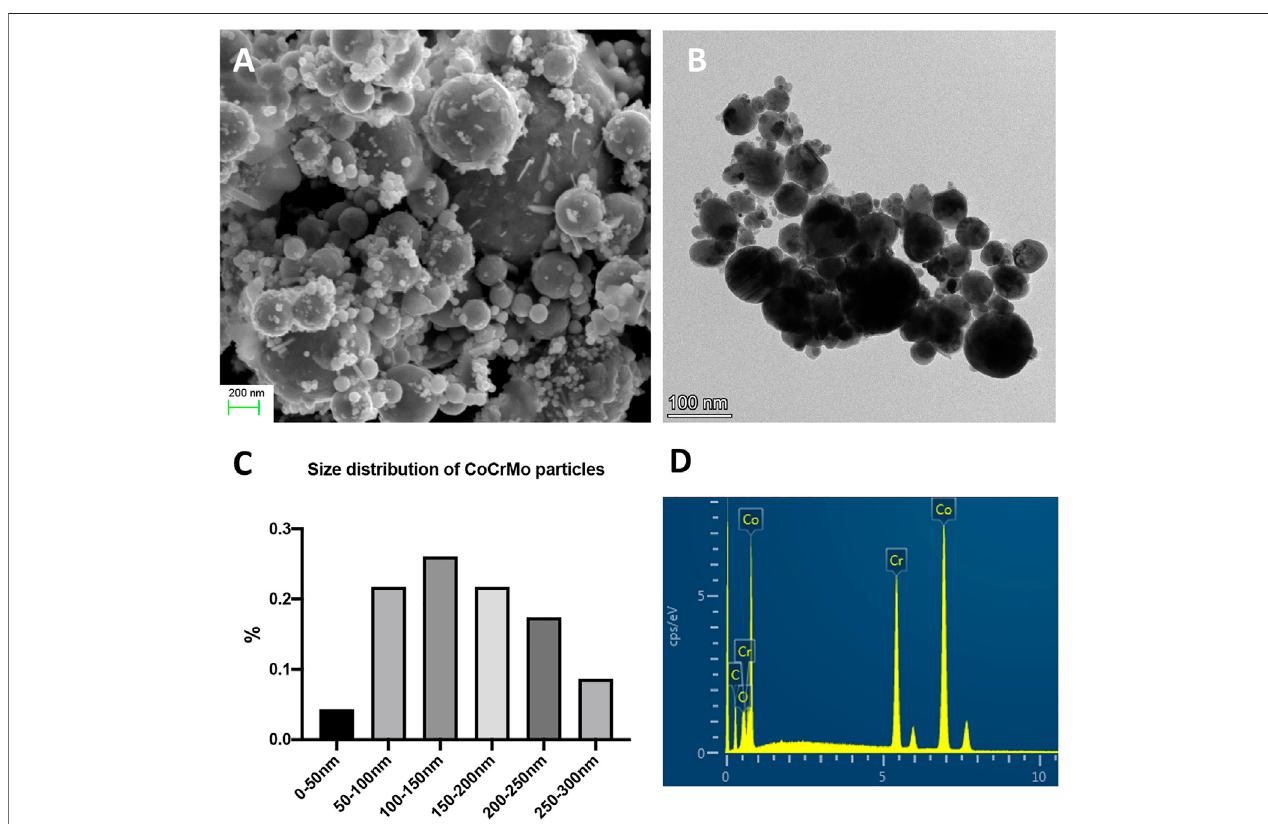
FIGURE 1 | The physical characteristics of CoCrMo nanoparticles derived from the femoral head implant of a patient who was diagnosed with aseptic loosening. (A) Scanning electron microscopy image of CoCrMo nanoparticles. (B) Transmission electron microscopy image of CoCrMo nanoparticles. (C) Size distribution of CoCrMo nanoparticles. (D) Chemical composition of CoCrMo nanoparticles.